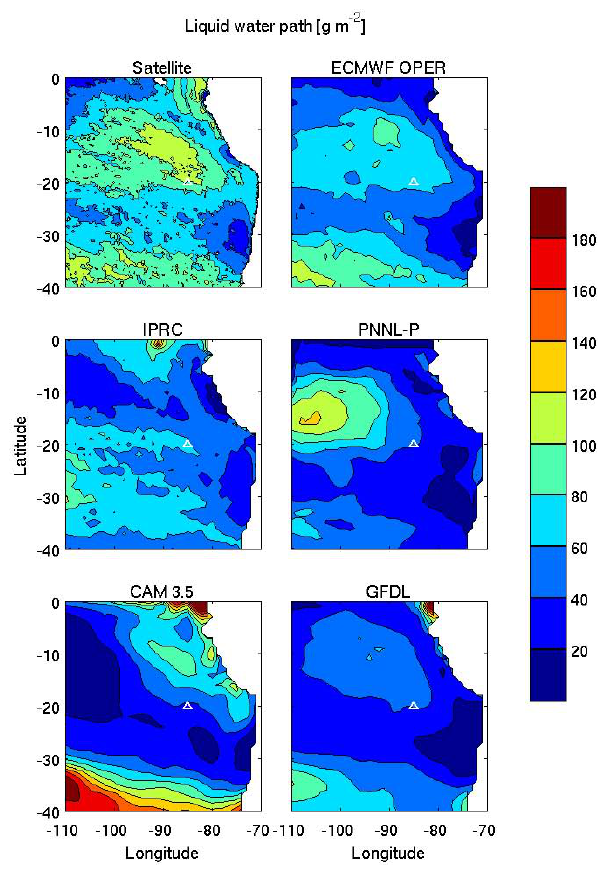
Fig. 5. October 2006 mean satellite liquid water path (upper left, gm − 2 ) and modeled liquid water path (gm − 2